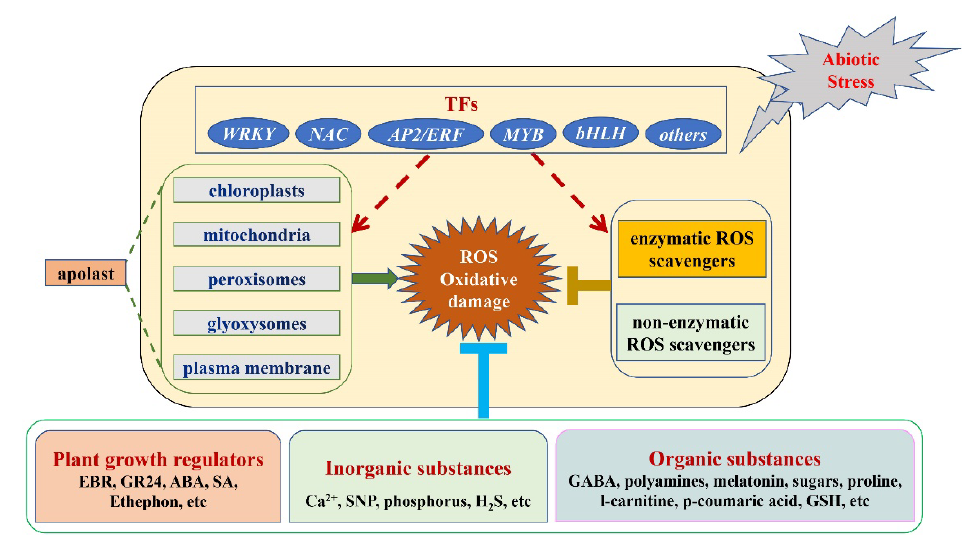
Figure 4. The model of transcription factors and exogenous substances regulate ROS metabolism under abiotic stress.